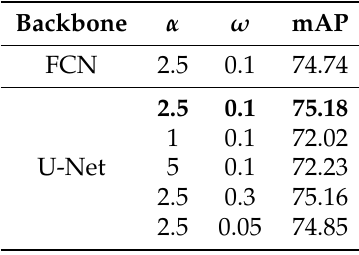
Table 6. Comparison of models trained with different α and ω values. All models were trained with an input size of 224 × 224. The batch size was set to 64.